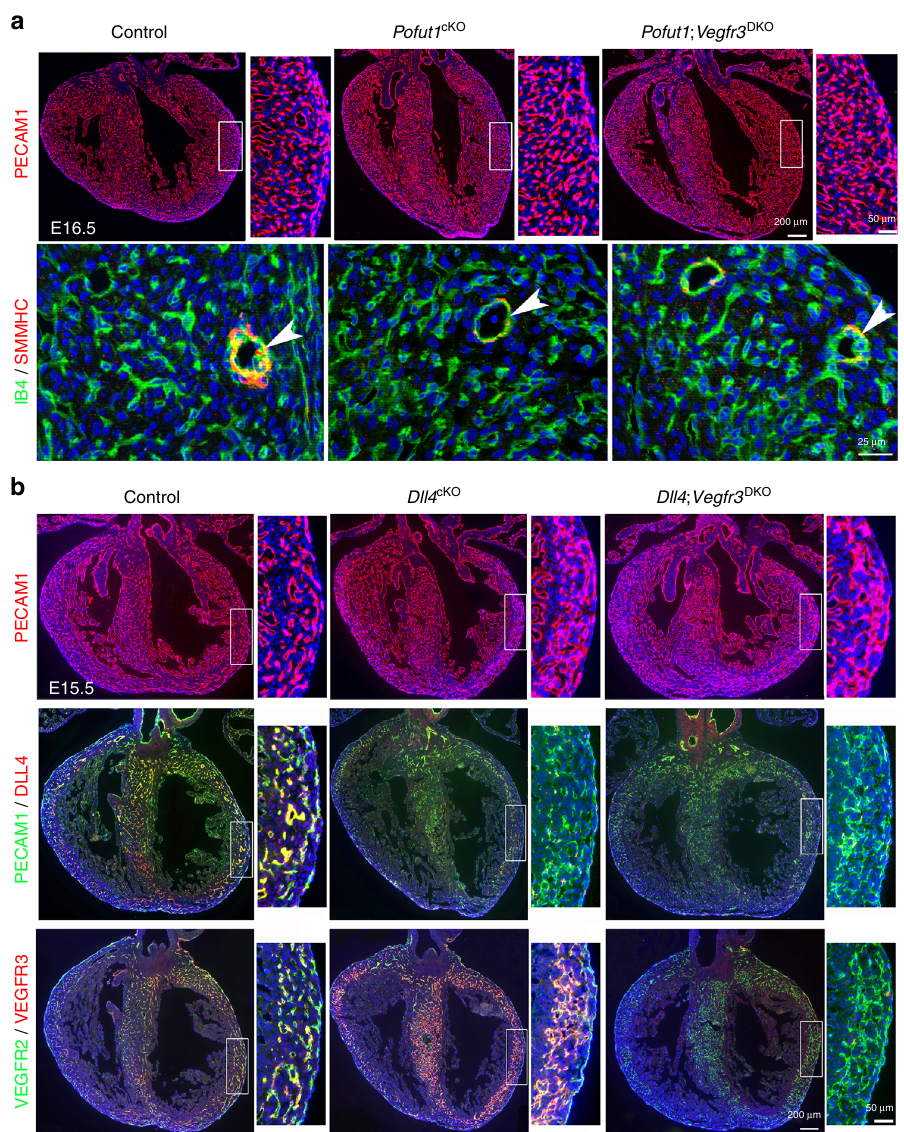
Fig. 5 Deletion of Vegfr3 fails to rescue coronary defects in Pofut1 cKO or Dll4 cKO mice. a PECAM1 staining and IB4/SMMHC co-staining shows increased coronaries in E16.5 heart with endocardial Pofut1 deletion, which cannot be rescued by simultaneous deletion of Vegfr3 . IB4 and SMMHC co-staining shows defective major coronary arteries ( arrowhead ) remain in the double mutants. b PECAM1 staining shows increased coronaries in E15.5 Dll4 cKO heart by induced Dll4 deletion at E14.5, which cannot be rescued by simultaneous deletion of Vegfr3 . PECAM1/DLL4 or VEGFR2/VEGFR3 co-staining shows effective deletion of Dll4 or